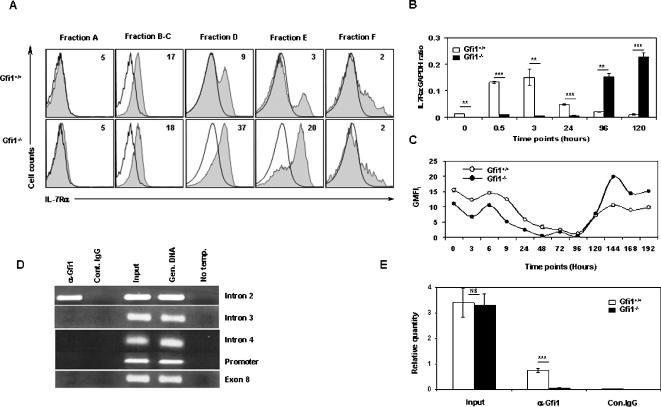
Modulation of IL7Rα expression by Gfi-1.A) Histograms plots indicating IL7Rα surface expression in distinct populations of bone marrow B lineage precursor cells. BM cells from 5 mice were pooled, and IL7Rα expression was analyzed in the following subpopulations: B220+CD43+BP1−CD24− (Fraction A), B220+CD43+CD24+ (Fraction B–C), B220+CD43−IgM− (Fraction D), B220+CD43−IgM+ (Fraction E), and B220highCD43−IgMhigh (Fraction F). Shaded histograms represent IL7Rα fluorescence and open histograms represent isotype fluorescence. The GMFIi is indicated in each plot. Geometric mean fluorescence intensity index was calculated as follows: GMFIi = GMFI(antibody stained cells)−GMFI(Isotype control treated cells). Data are representative of 5 independent experiments. B–C) Realtime PCR showing IL7Rα RNA and surface expression levels during in vitro B cell development. LSK bone marrow cells isolated from Gfi1+/+ and Gfi1−/− mice were first expanded for 48 hours in a cytokine cocktail containing IL3, IL6, SCF, Flt3L, TPO and then cultured in the presence of SCF and IL7. RNA was extracted at indicated time points, reverse transcribed into cDNA and Realtime PCR was performed (B). Cell surface expression of IL7Rα during in vitro B cell differentiation. LSK bone marrow cells of Gfi1+/+ and Gfi1−/− mice were cultured in the presence of SCF and IL7. Aliquots of cells were taken at indicated time points and analyzed for expression of IL7Rα by FACS (C). Shown are the mean values of duplicate samples. Data are representative of 2 independent experiments. D) Chromatin-immunoprecipitation analysis of Gfi1 binding to the IL7Rα gene. Crosslinked chromatin from Gfi1+/+ bone marrow B220+ cells was immunoprecipitated using control goat IgG or anti-Gfi1 antibodies. PCR was performed on input DNA and immunoprecipitated DNA using primer pairs spanning Gfi1 binding sites that are present in intron 2, intron 3, intron 4, promoter and exon 8 of the IL7Rα gene, respectively. Genomic DNA and no template lanes represent controls. Data are representative of 2 independent experiments. E) Semi-quantitative real time PCR analysis. Crosslinked chromatin from Gfi1+/+ and Gfi1−/− bone marrow B220+ cells was immunoprecipitated using control goat IgG or anti-Gfi1 antibodies. Realtime PCR was performed on input and immunoprecipitated DNA using primer pairs spanning Gfi1 binding sites in intron 2 of IL7Rα gene. Data are representative of 2 independent experiments.